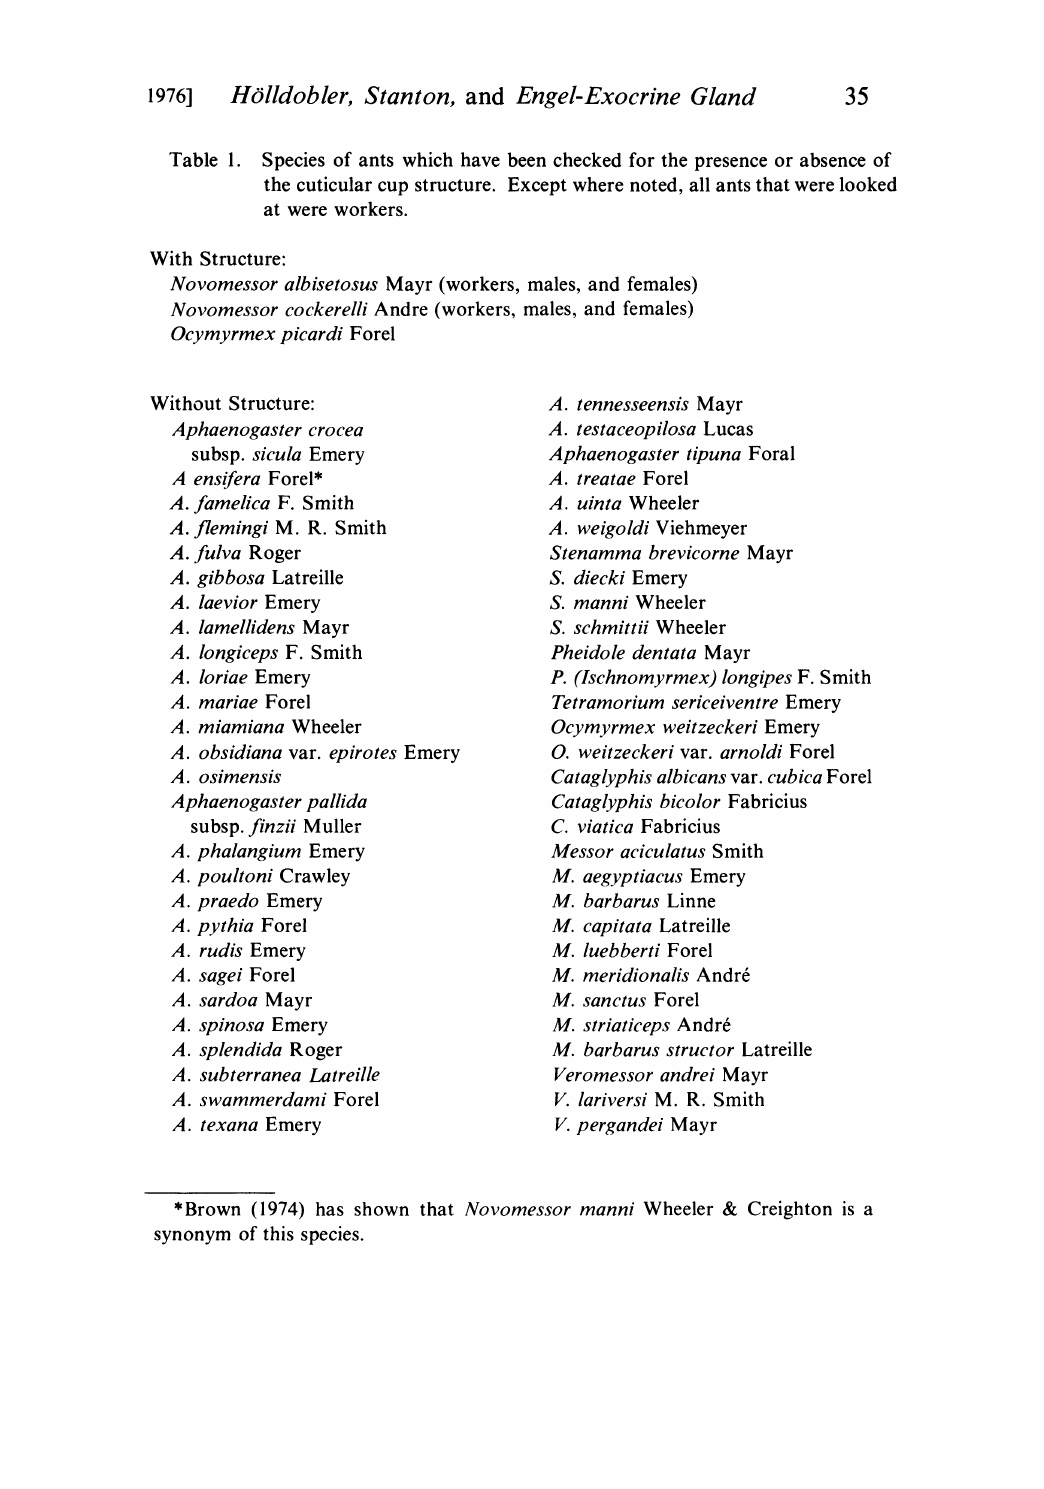
Table 1. Species of ants which have been checked for the presence or absence of the cuticular cup structure. Except where noted, all ants that were looked at were